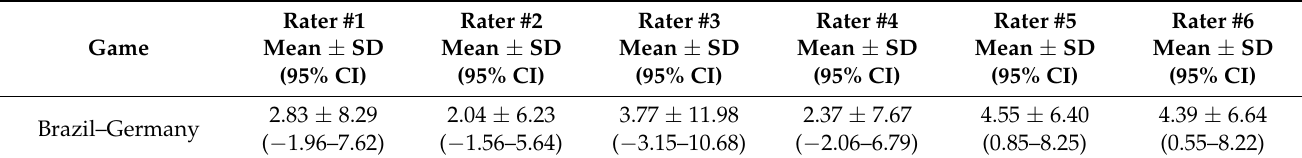
Table 3. Mean value, standard deviation ( ± SD) and 95% confidence intervals (95% CI) for the PlayerScores, separate by the six raters and six games.